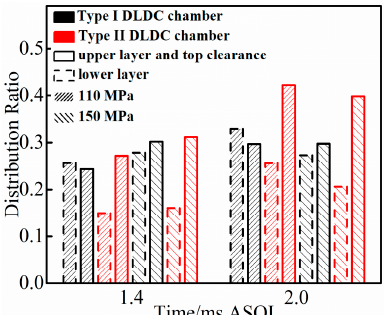
Figure 12. The fuel spray distribution ratios at different times with medium load, Φ 0.16 mm nozzle, different injection pressures and 5 °CA BTDC injection timing of Mode A.